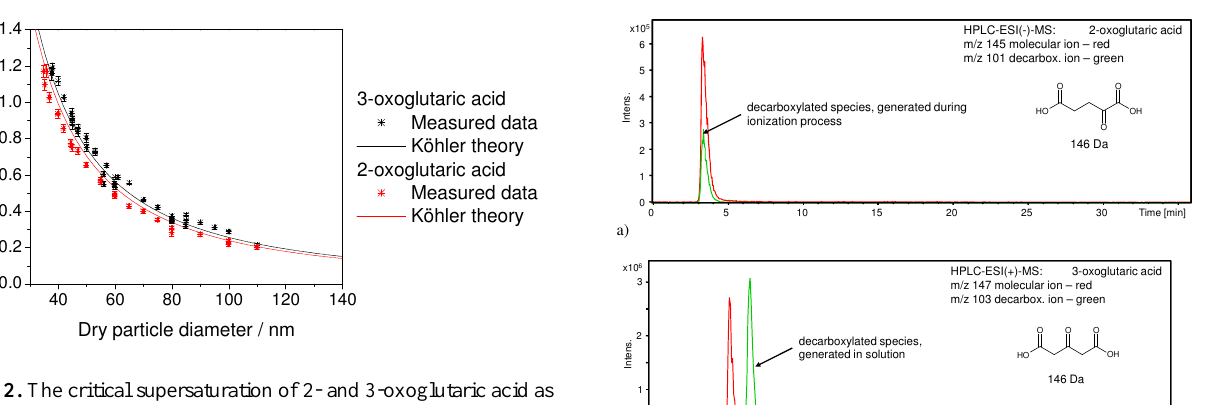
Fig. 12. The critical supersaturation of 2- and 3-oxoglutaric acid as a function of dry particle diameter. The experimental data is fitted to a K¨ohler curve (surface tension of water, dissociation calculated from acid constants).